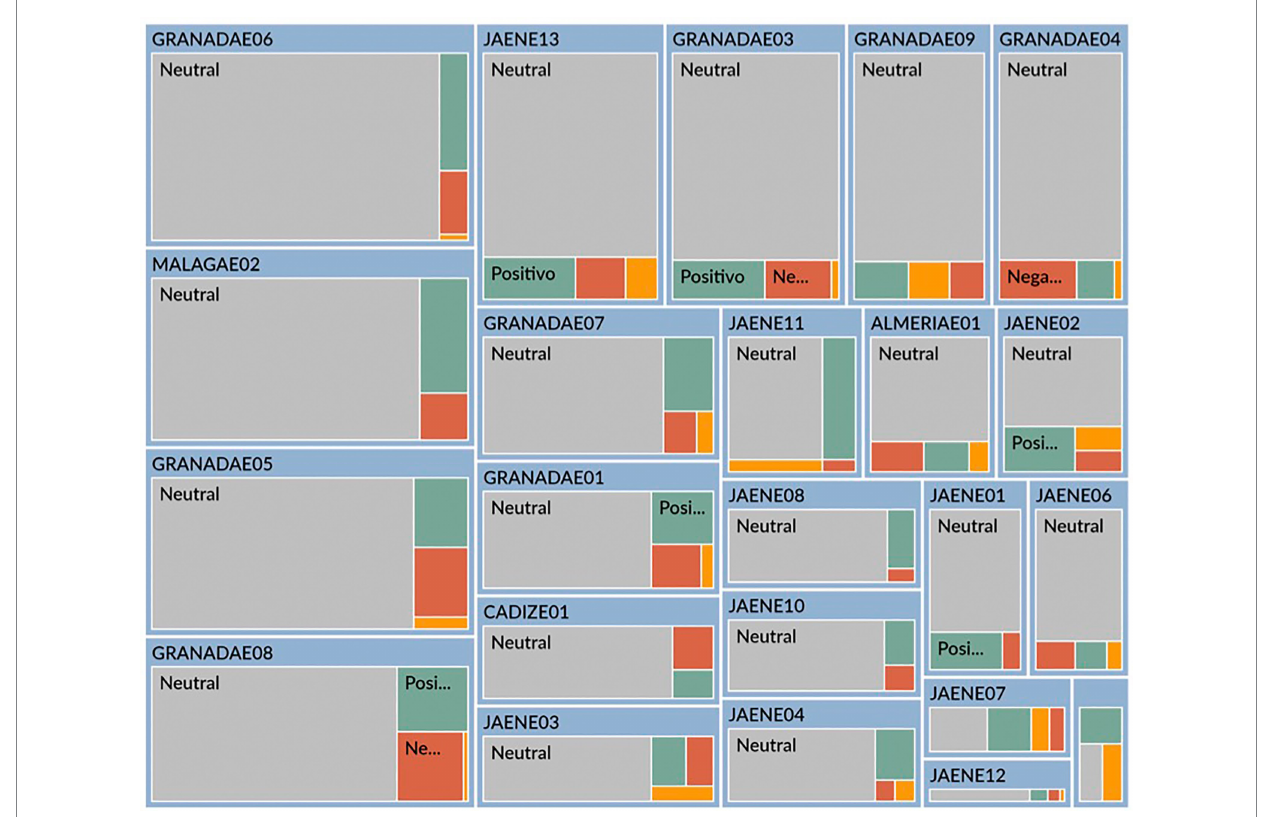
FIGURE 8 Representation of self-coding based on feelings. Caption (top to bottom-left to right): (A) GRANADAE06 (Neutral), (B) MALAGAE02 (Neutral), (C) GRANADAE05 (Neutral), (D) GRANADAE08 (Neutral), (E) JAENE13 (Neutral), (F) GRANADAE07 (Neutral), (G) GRANADAE01 (Neutral), (H) CADIZE01 (Neutral), (I) JAENE03 (Neutral), (J) GRANADAE03 (Neutral), (K) JAENE11 (Neutral), (L) JAENE08 (Neutral), (M) JAENE10 (Neutral), (N) JAENEE04 (Neutral), (Ñ) GRANADAE09 (Neutral), (O) ALMERÍAE01 (Neutral), (P) JAENE01 (Neutral), (Q) JAENE07 (Neutral), (R) JAENE12 (Neutral), (S) GRANADAE04 (Neutral), (T) JAENE02 (Neutral), (U) JAENE06